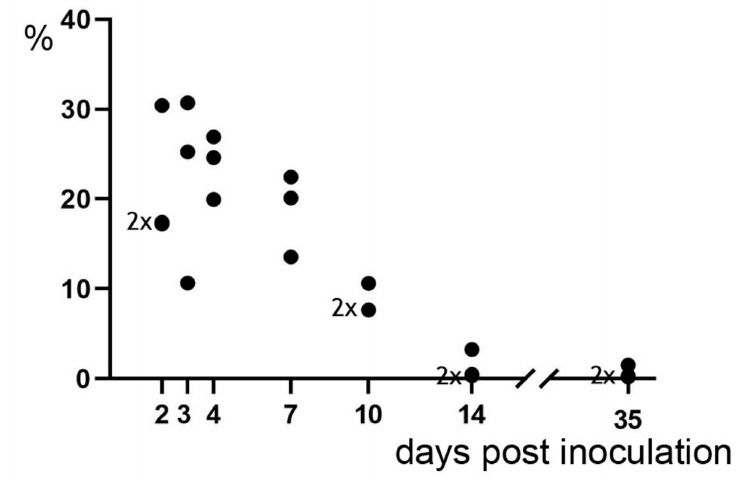
Figure 1. Percentage of pulmonary tissue with lesions at 2, 3, 4, 7, 10, 14 and 35 / 37 dpi. Each point in the diagram represents one or two (2 × ) individual